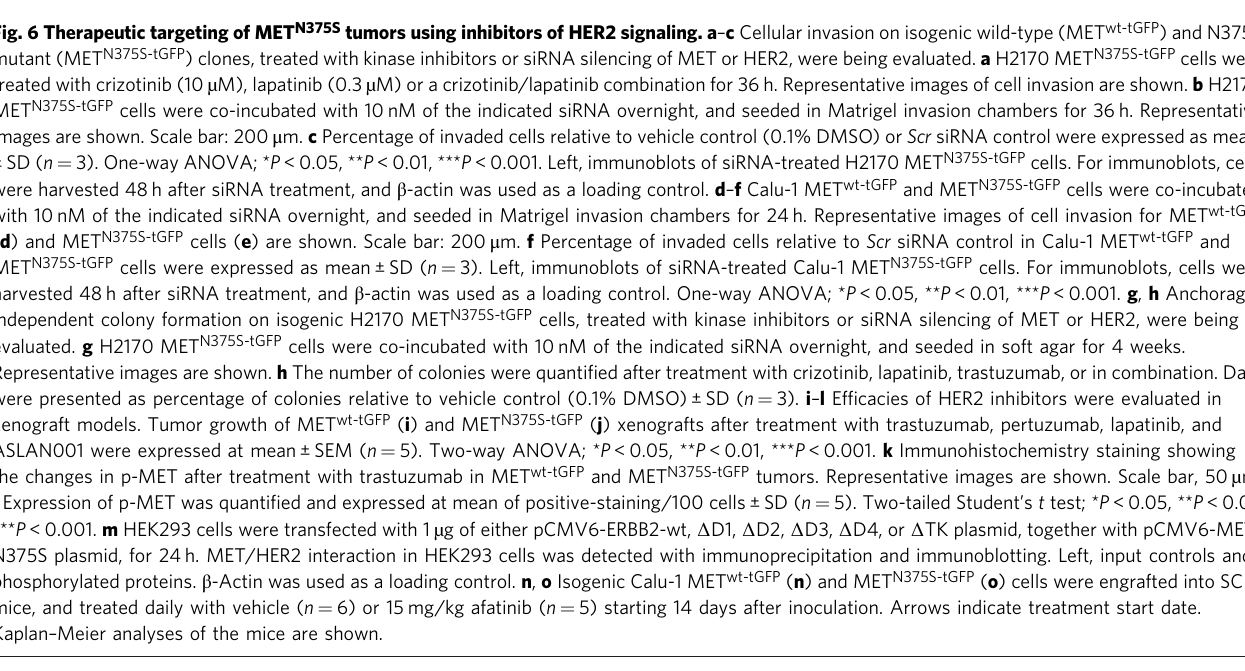
Fig. 6 Therapeutic targeting of MET N375S tumors using inhibitors of HER2 signaling. a – c Cellular invasion on isogenic wild-type (MET wt-tGFP ) and N375S mutant (MET N375S-tGFP ) clones, treated with kinase inhibitors or siRNA silencing of MET or HER2, were being evaluated. a H2170 MET N375S-tGFP cells were treated with crizotinib (10 µ M), lapatinib (0.3 µ M) or a crizotinib/lapatinib combination for 36 h. Representative images of cell invasion are shown. b H2170 MET N375S-tGFP cells were co-incubated with 10 nM of the indicated siRNA overnight, and seeded in Matrigel invasion chambers for 36 h.